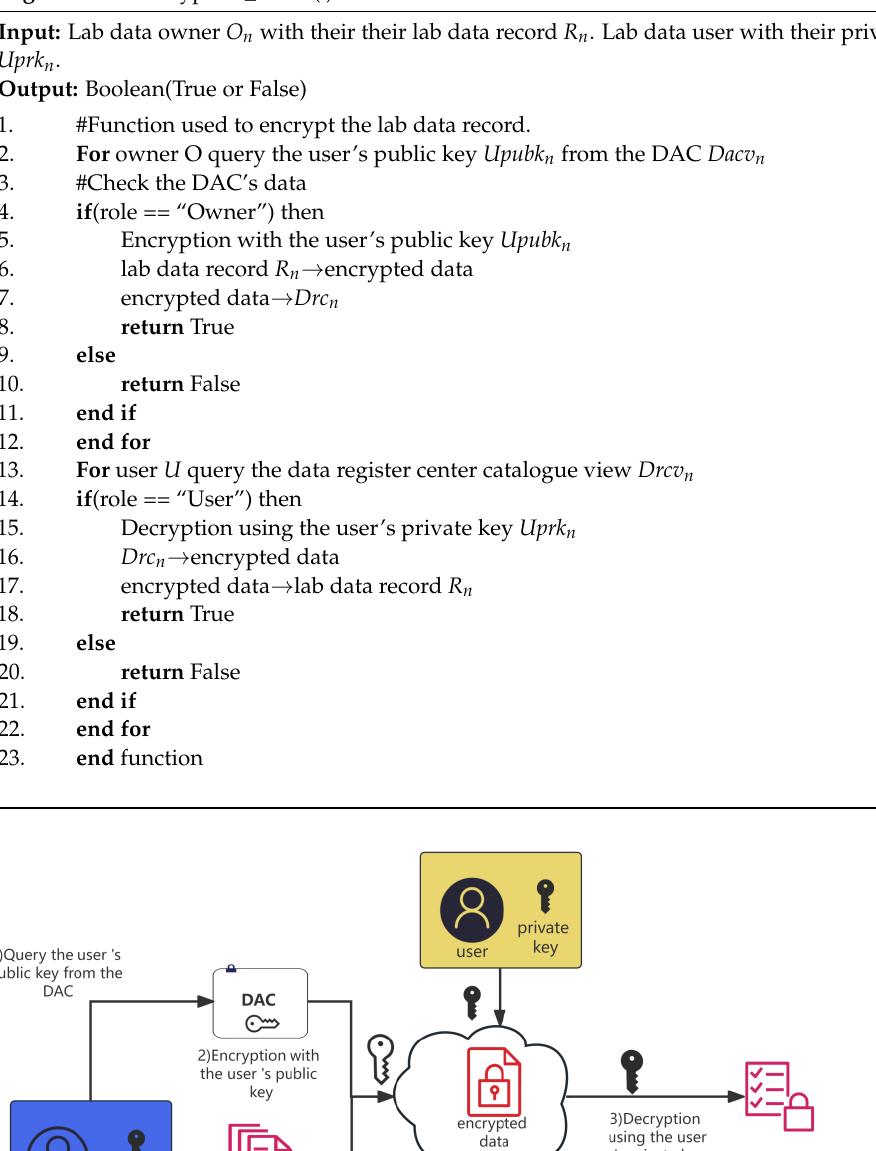
Algorithm 1. Encryption_Once ( )